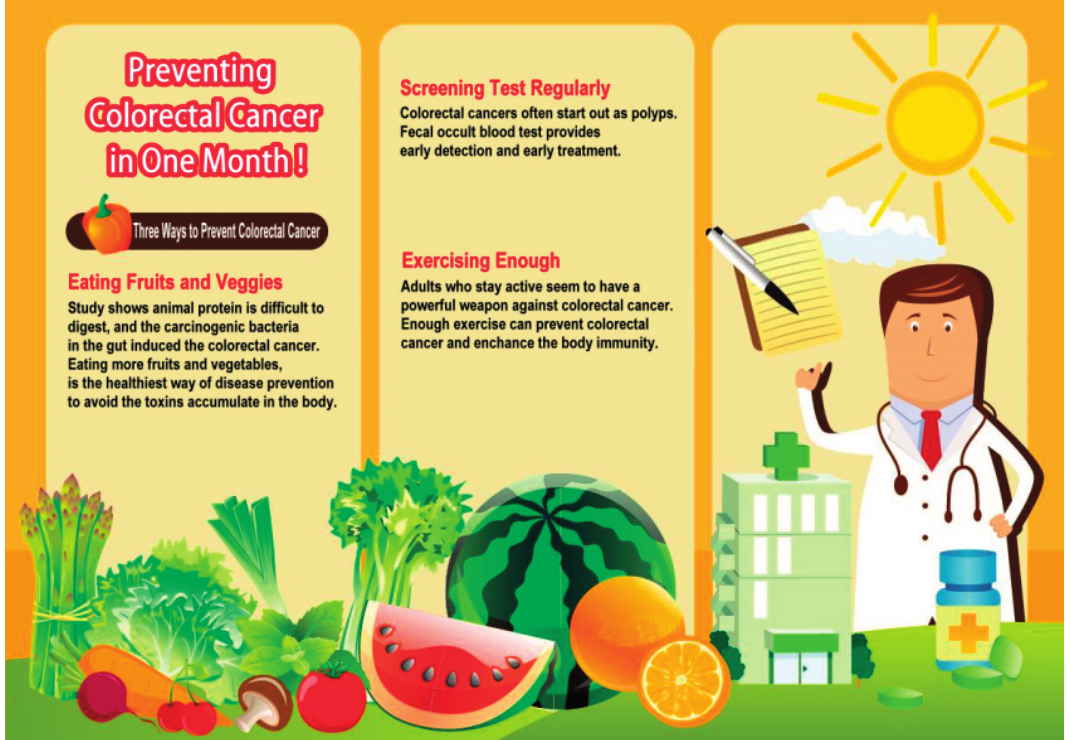
Figure 3. Prevention focus, one month and many graphics and little